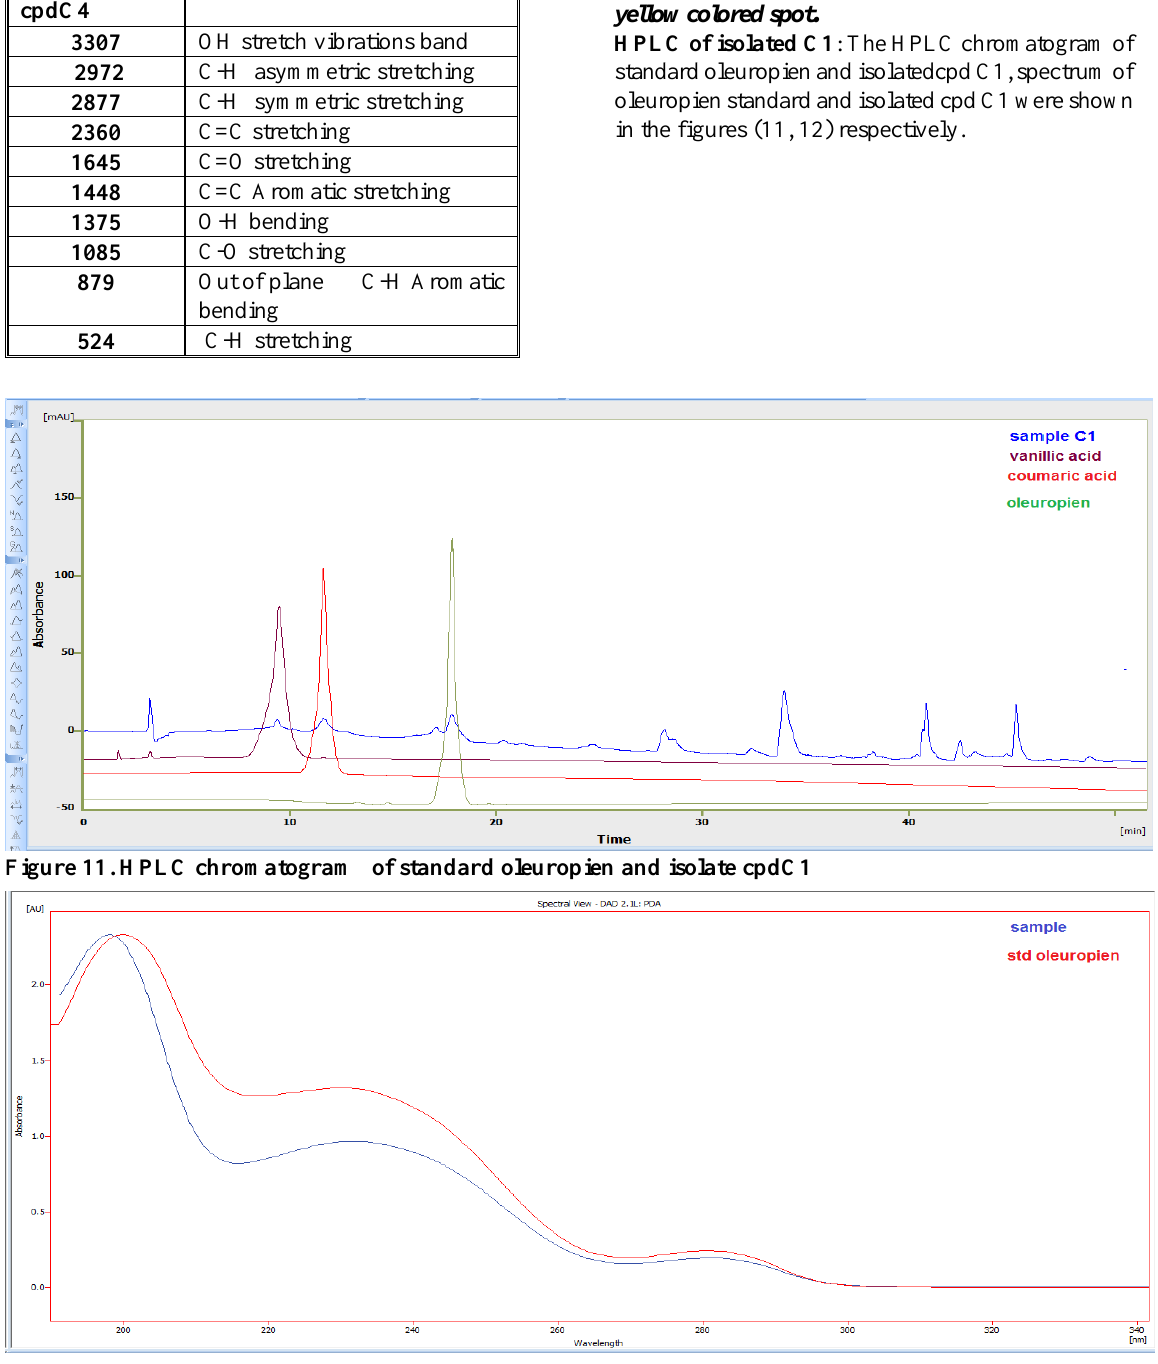
Figure 12. UV spectrum of standard oleuropien and isolate cpdC1 FTIR: IR spectrum of isolated cpd C1 is showed in the figure (13) and interpretation of the bands in